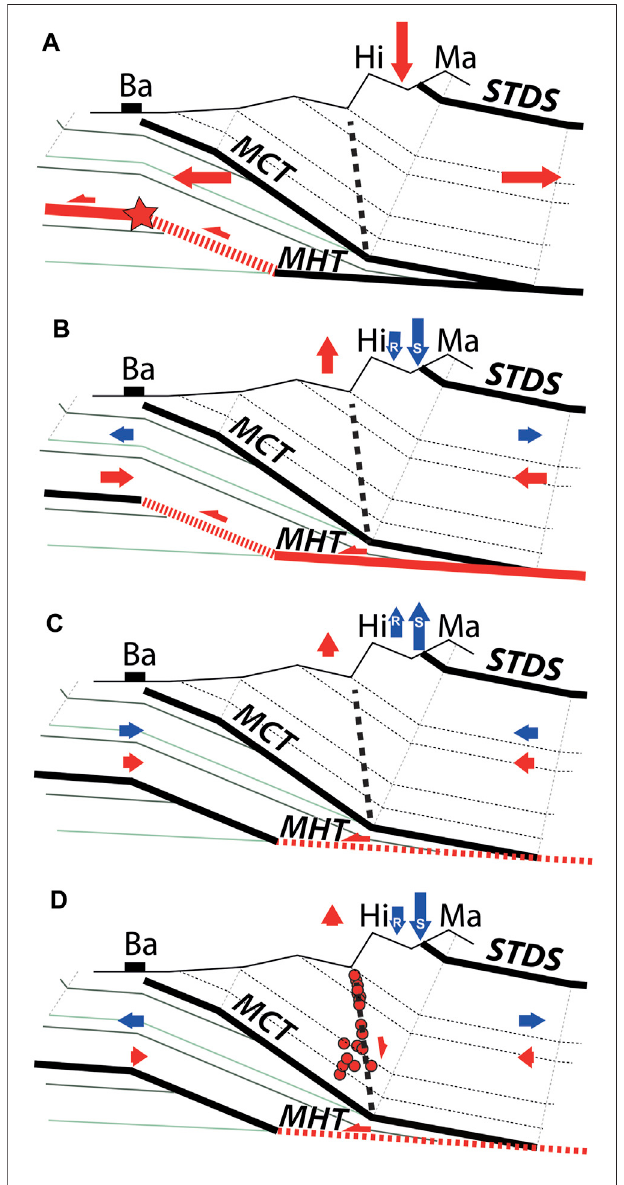
FIGURE 4 | Conceptual model of the transient and seasonal straining and the seismic swarm (see text). Geological section is deduced from fi eld mapping (Colchen et al., 1986). Ba, Hi, and Ma stand for Barpak, Himalchuli, and Manaslu, respectively. MHT, MCT, and STDS stand for Main Himalayan Thrust, Main Central Thrust, and Southern Tibetan Detachment System, respectively. The bold dashed line corresponds to the fault activated during the seismic crisis. The red arrows are related to the effects of the tectonic forcing. The blue arrows are related to the effects of the hydrological surface loads, R for Regional, S for local Snow load. (A) April 25, 2015. Coseismicdamage,followingtheruptureoftheupperdecollementoftheMHT in red, generates localized extension and subsidence of the High range. (B) Summer 2015. Afterslip associated with immediate fault clamping. (C) Fall- Winter 2016. Seasonal fault clamping resulting from tectonics, regional and local straining. (D) August 2017. Orogenic collapse and/or fl uid/gas migration associated with seasonal extension related to regional seasonal straining and local snow loading. Hypocenters from relocated earthquakes are shown as red circles (plotted in Figure 3C